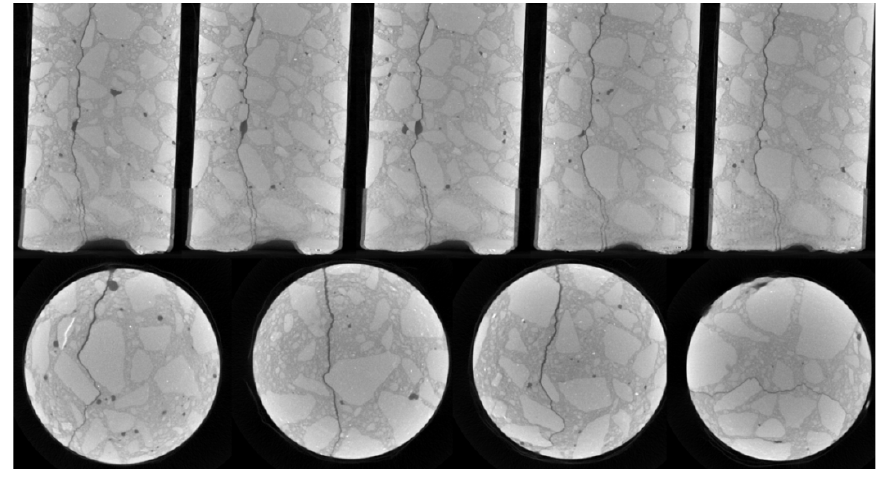
Figure 7. Type-I crack .